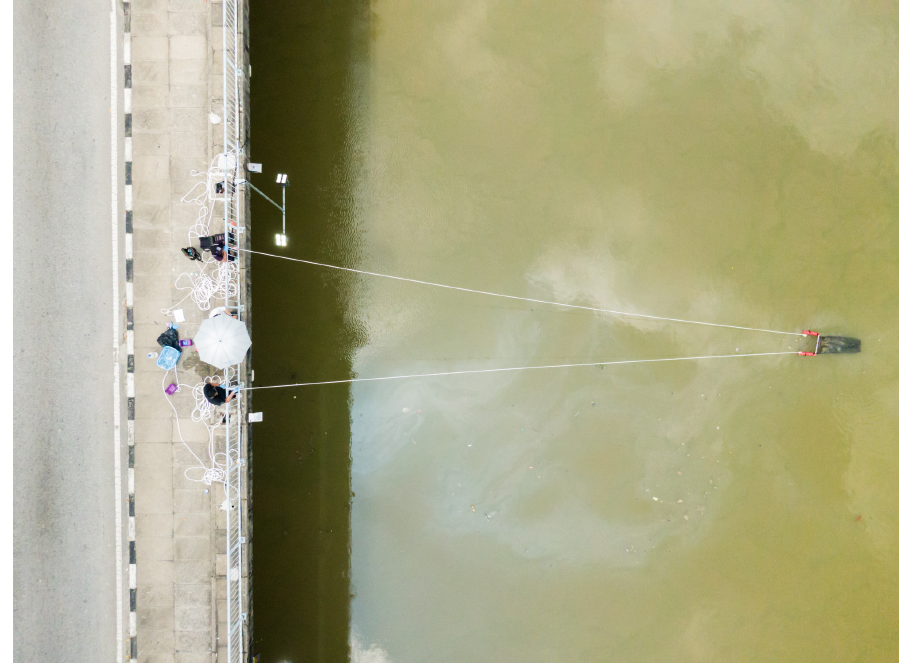
Figure 4. Deployment of the sampling net at the additional plastic sampling location (Credit: Florent